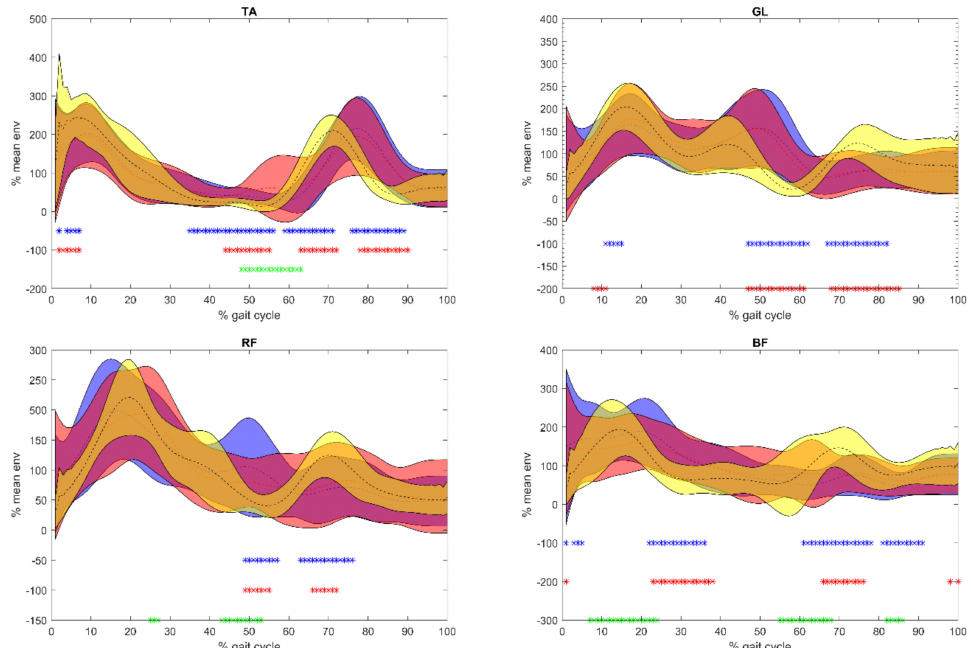
Figure 3. Envelope mean ± 1 standard deviation extracted from the surface electromyographic signal of each muscle analyzed: On the y-axis, the peak of the envelope (PoE in % of mean activation during gait), on the x-axis, the gait cycle (from 0 to 100%). The bottom on the left tibialis anterior (TA) and on the right gastrocnemius lateralis (GL); down on the left rectus femoris (RF) and on the right biceps femoris (BF). In blue PoE before Equistasi ® , in red after Equistasi ® , and in yellow normative bands of control subjects. Blue *: Before Equistasi ® compared with controls; red *: After Equistasi ® compared with controls; green *: Before Equistasi ® compared with controls after Equistasi ®